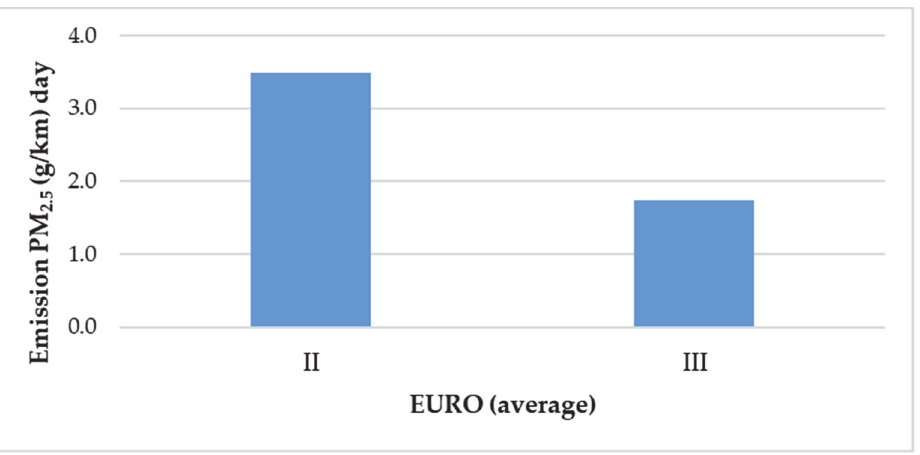
Figure 11. Emission PM 2.5 vs. Euro.